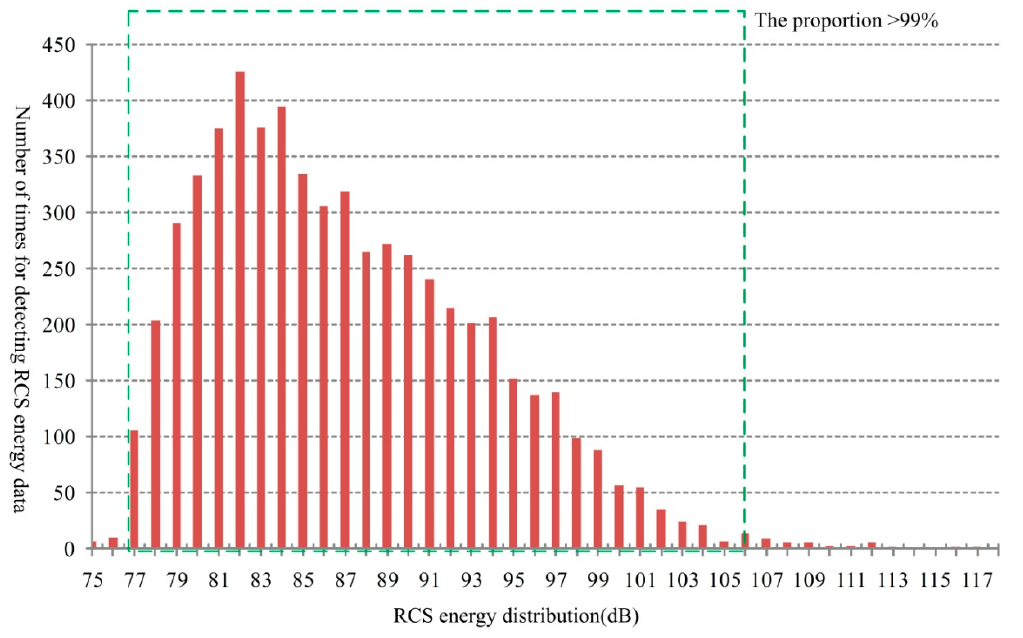
Figure 8. Distribution of the number of times for RCS energy measurement.